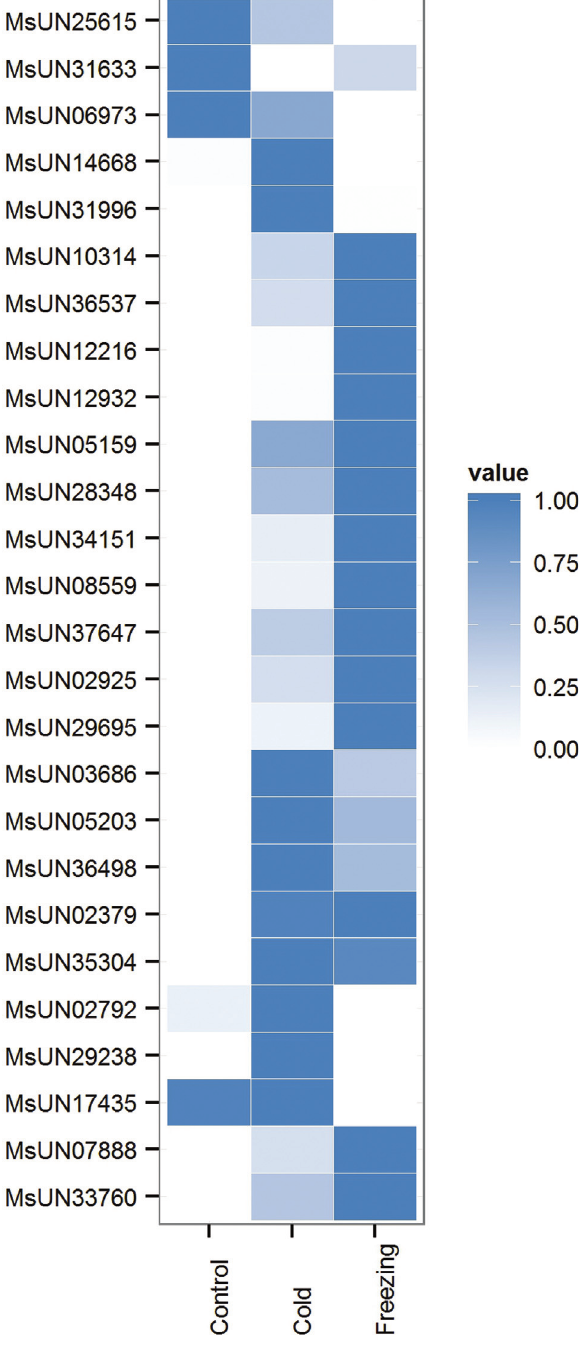
Figure 7 - Expression profile of AP2/ERF transcript factors differentially expressed in response to cold and/or freezing stress.